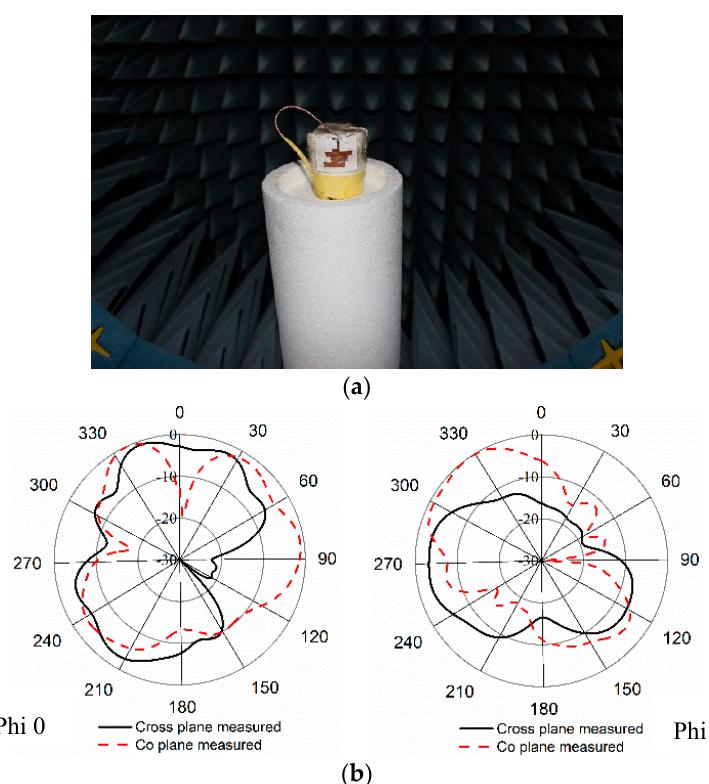
Figure 18. ( a ) Radiation pattern measurement of the proposed paper-based antenna with phantom muscle; ( b ) radiation patterns of the antenna mounted on a muscle phantom at Phi 0 and at Phi 90.